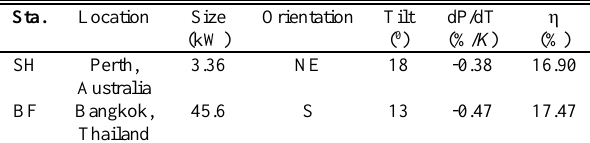
Table 1. Actual solar PV installations in PVOutput.org used for validation of monthly and seasonal model outputs.